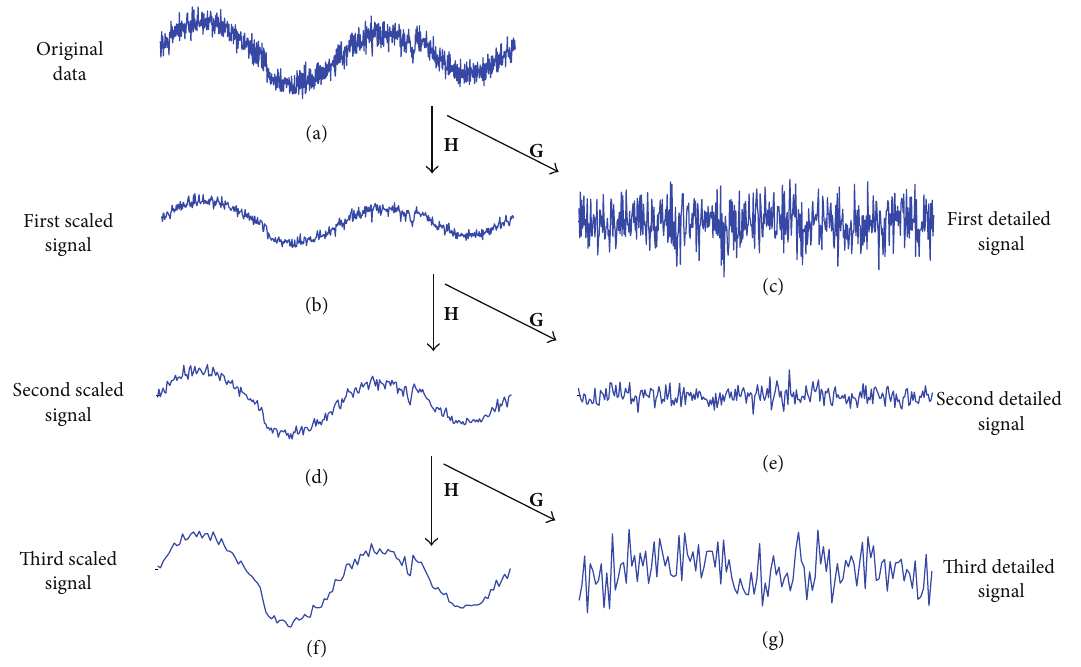
Figure 1: Multiscale decomposition of a heavy-sine signal using